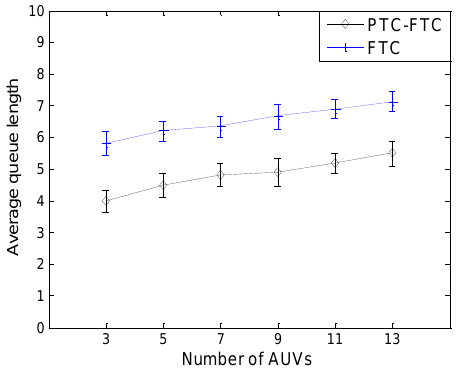
Figure 15. The average queue length of PTC-FTC and FTC.